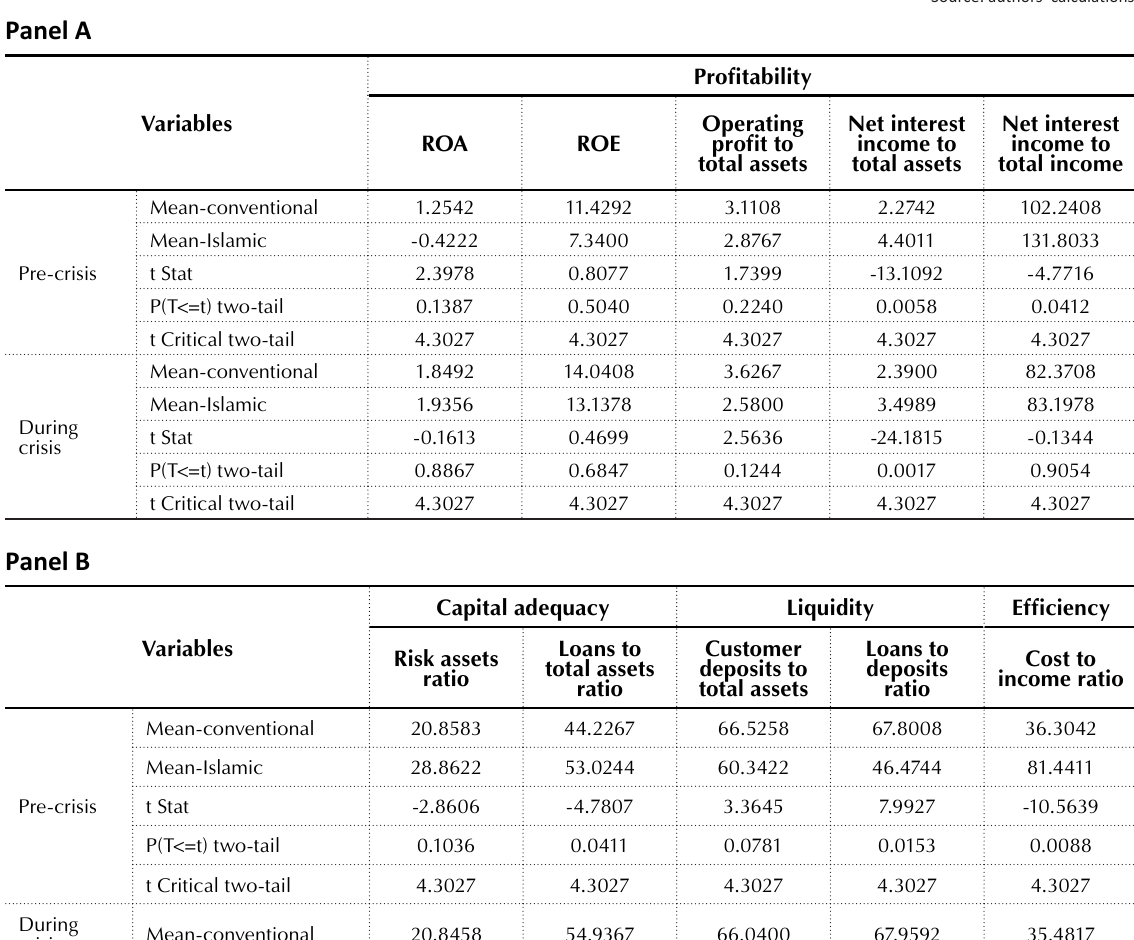
Table 7. t-test on conventional & Islamic